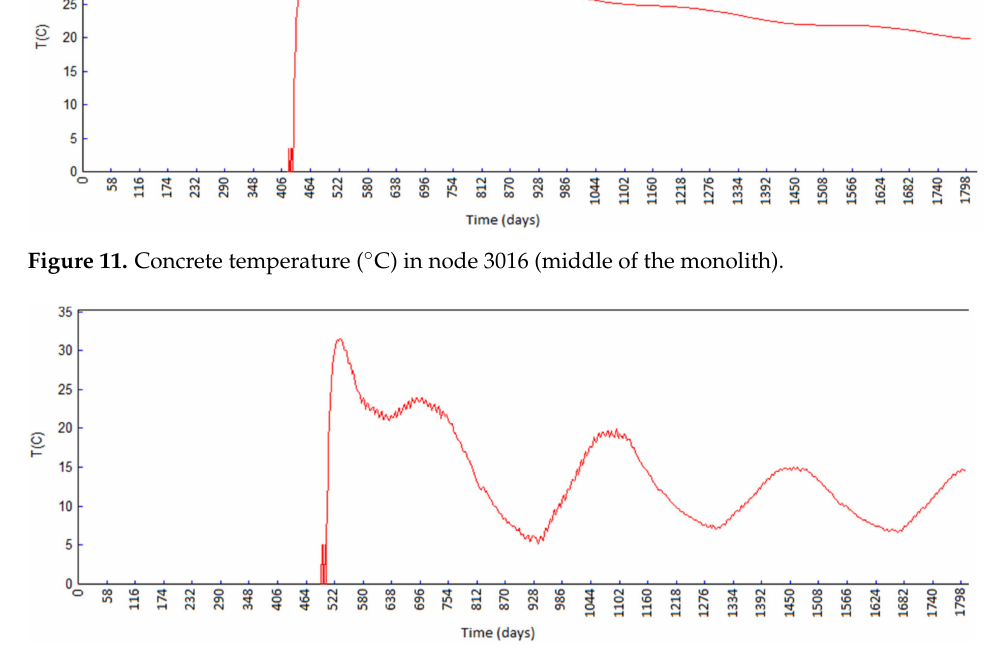
Figure 12. Concrete temperature ( ◦ C) in node 3184 (zone of the dam’s